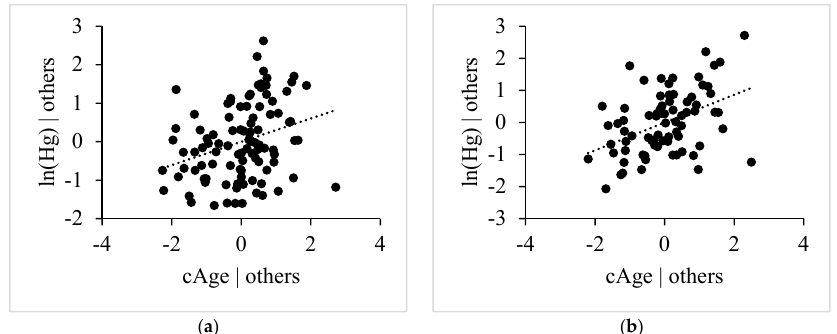
Figure 5. Partial linear regressions between the centered, transformed age and logarithmically transformed Tot-Hg-concentration; ( a ) added variable plot for E. smelt; ( b ) added variable plot for whitefish.